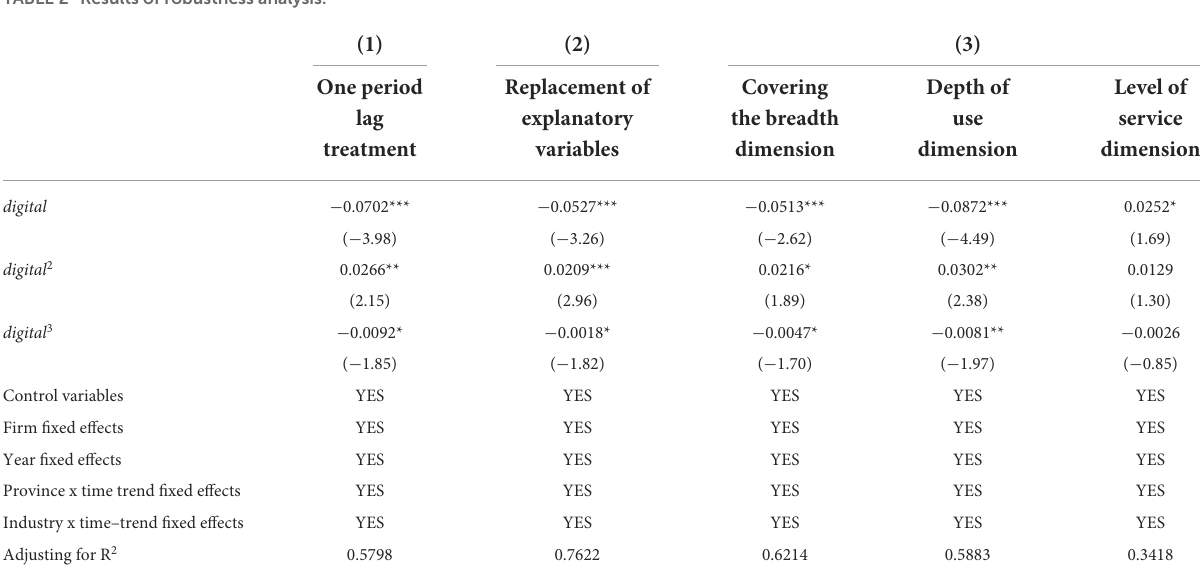
TABLE 2 Results of robustness